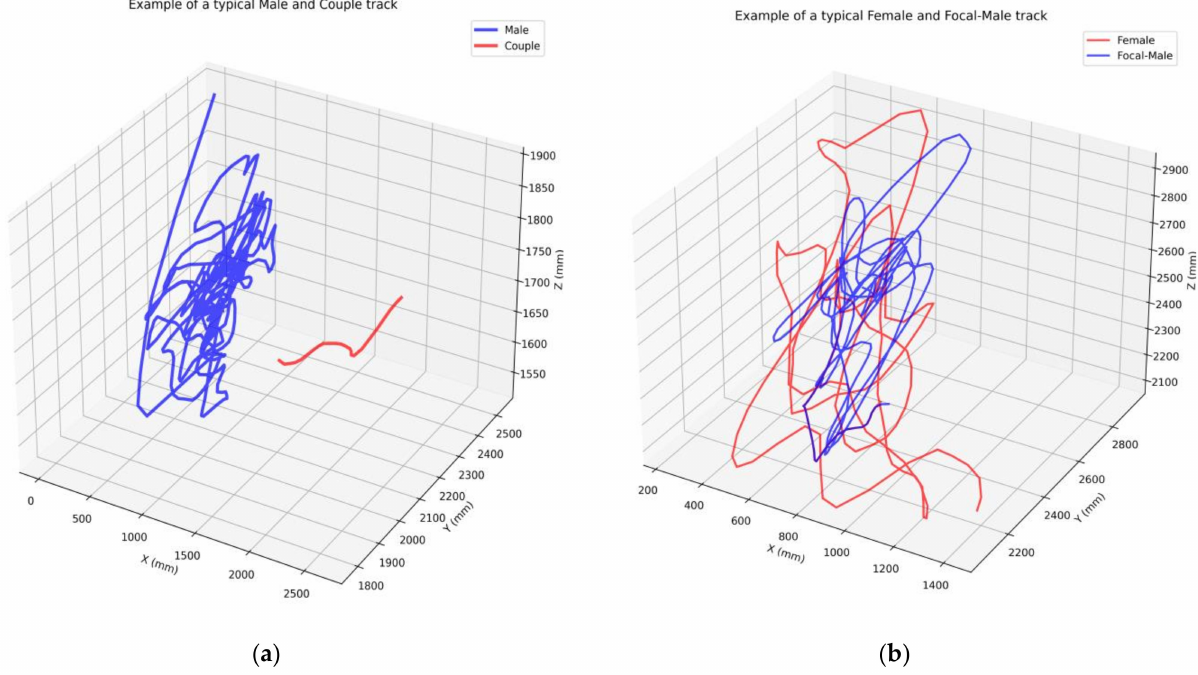
Figure 1. Example of typical tracks. ( a ) Example of a typical single male mosquito and a mating couple track. The red and blue lines display the mating couple and single male paths, respectively. ( b ) Example of a mosquito mating sequence. The red and blue lines display the female and focal-male paths, respectively. At the end of this sequence, they form a mating